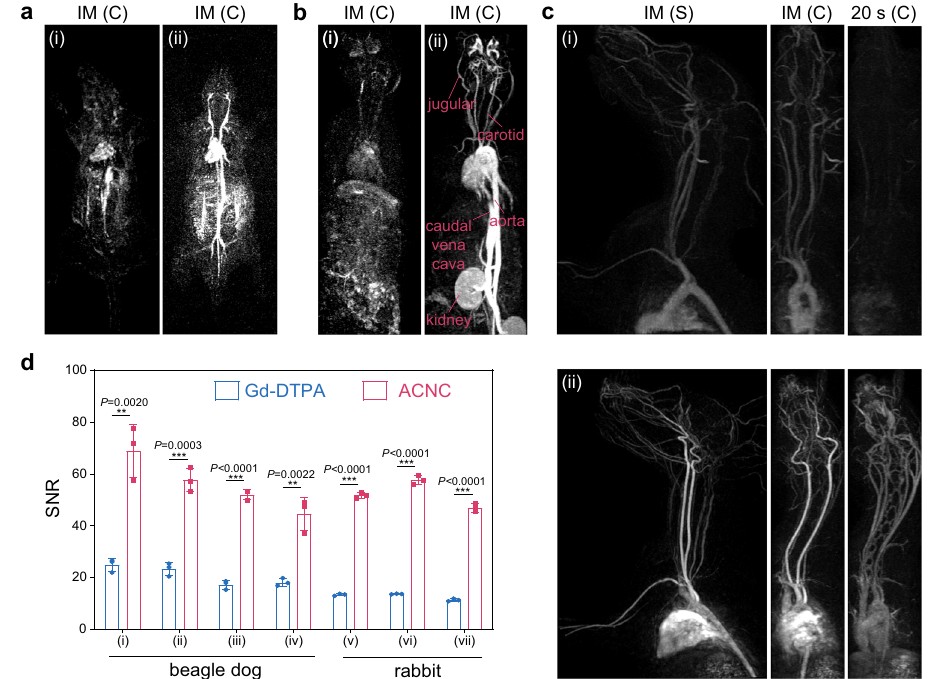
Fig. 5 | Invivo MR angiography. a , b Contrast-enhanced MR angiography (MRA) images of the whole body on a rat and b rabbit immediately after the bolus injection of (i) Gd-DTPA and (ii) ACNC. c MRA images of upper body on beagle dog at immediately (IM) and 20s after the bolus injection of (i) Gd-DTPA and (ii) ACNC, respectively. (C) and (S) represents coronal plane and sagittal plane respectively. d Quantitative measurement of SNR of ROIs in (i) brachiocephalic